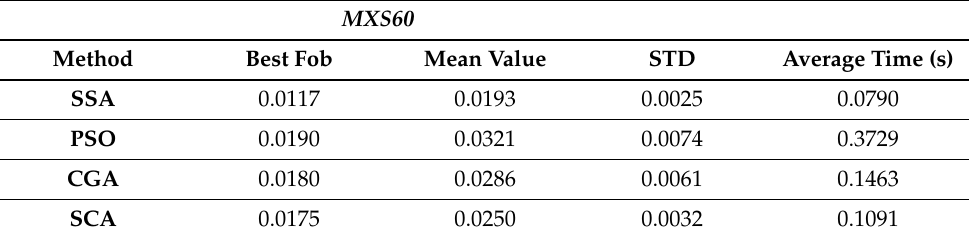
Table 10. Averaged results obtained for the MSX 60 PV panel under the 500 W/m 2 and 1000 W/m 2 irradiance